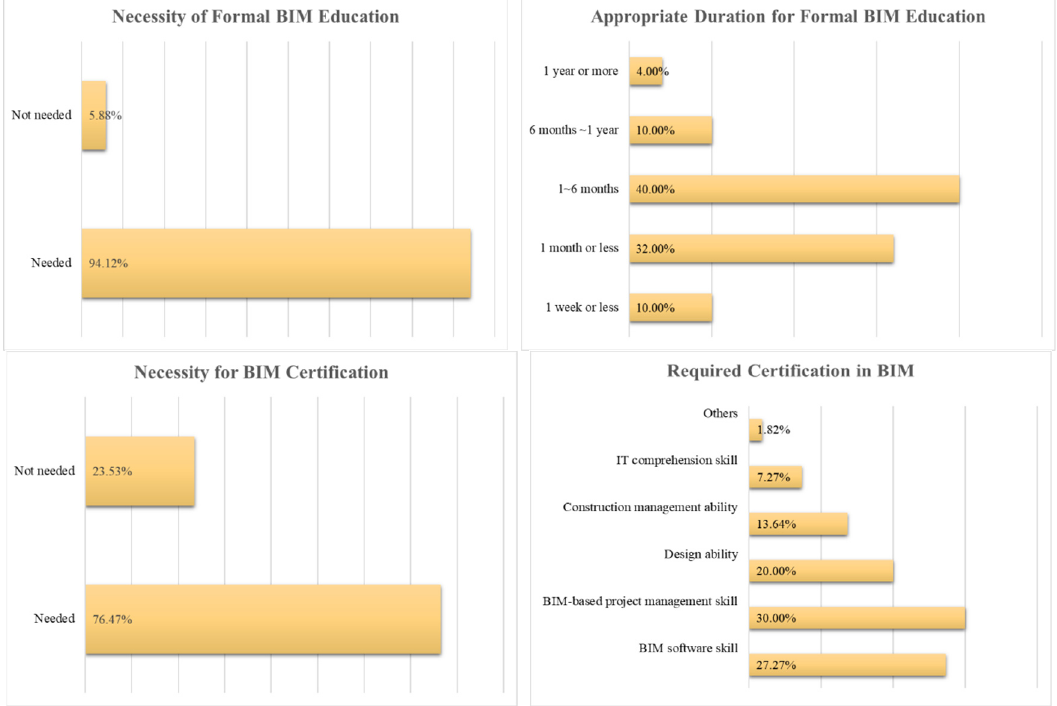
Figure 2. Responses about BIM Education and Certificate System.